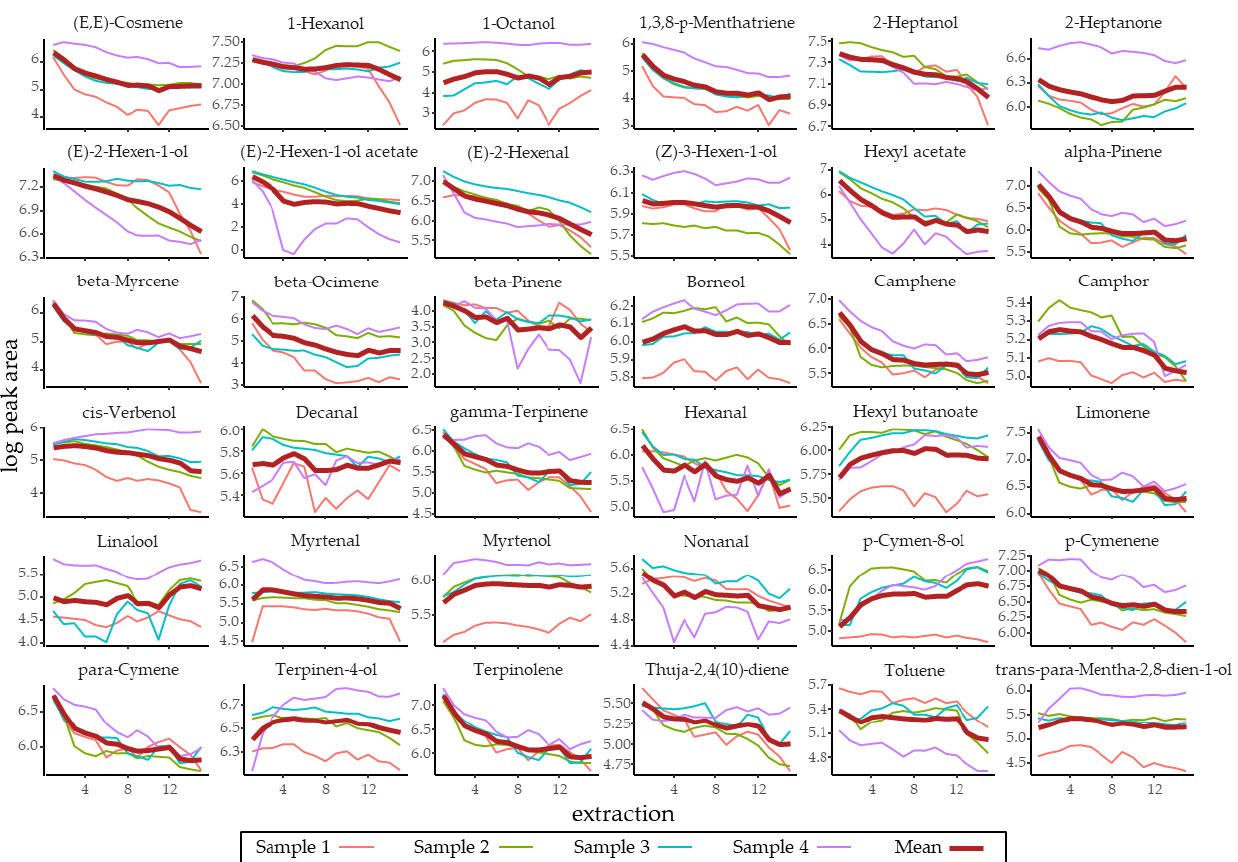
Figure 2. Measured peak areas over subsequent multiple headspace SPME extractions and GC-MS runs for all the identified Rubus fruticosus volatiles. The different samples are shown as a thin line. The thicker dark red line shows the geometric mean of the four samples, which was used to calculate the total peak area over the subsequent extractions, and which in combination with response factors measured from pure compounds allowed us to estimate the total amount (volume) of each volatile produced by a single R. fruticosus berry.